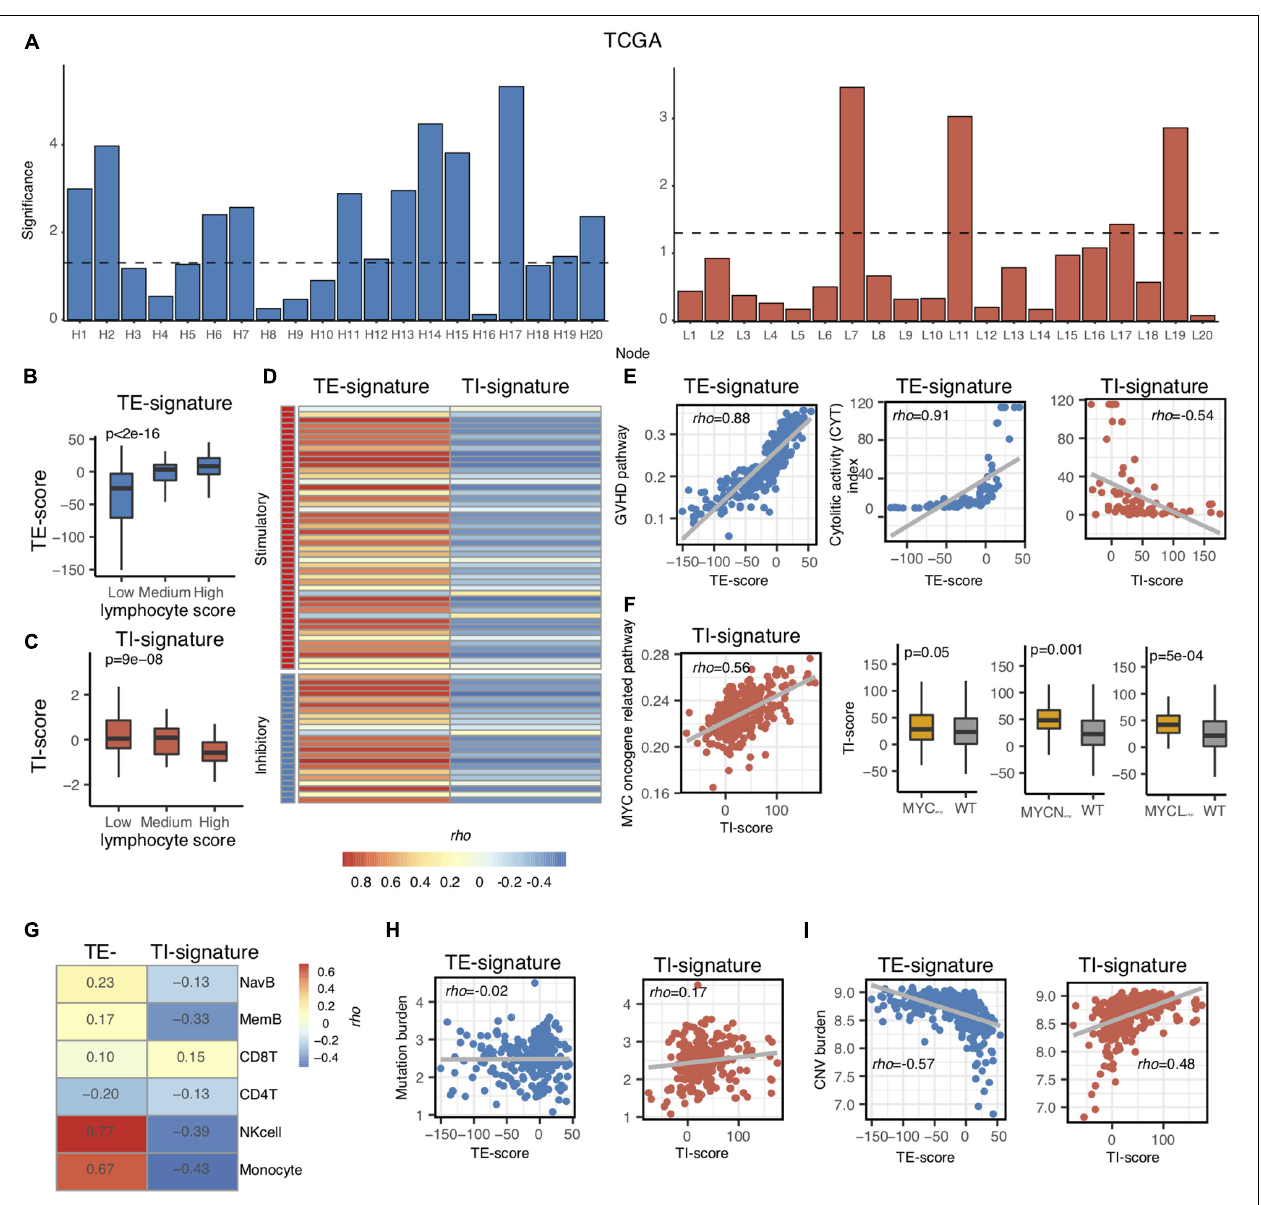
FIGURE 2 | Association of TI and TE signatures with molecular and immunological features. (A) Bar plot showing the –log10 ( p -value) of each node in the TCGA metastatic melanoma dataset. (B,C) Boxplot showing the association between TE-signature score and lymphocyte score in (B) and between TI-signature score and lymphocyte score in (C) . P -value was calculated by ANOVA. (D) Heat map showing the correlation between immune stimulatory or immune inhibitory gene expression and TE-signature or TI-signature scores. (E) Scatterplot showing the correlation between GVHD pathway activity and TE-signature score (left panel) or showing the correlation between CYT index and TE-signature or TI-signature scores (right panel). (F) Scatterplot showing the correlation between MYC oncogene pathway activity and TI-signature score. Boxplot indicating the TI-signature scores difference between MYC amp or MYCN amp or MYCL amp and WT. P -values were calculated by Wilcoxon rank-sum test. (G) Heat map showing the correlation between TE-signature or TI-signature scores and immune cell abundance. (H) Scatterplot showing the correlation between Mutation burden and TE-signature (left panel) or TI-signature (right panel) scores. (I) Scatterplot showing the correlation between CNV burden and TE-signature (left panel) or TI-signature (right panel) scores. In all scatterplots, the rho was calculated by Spearman